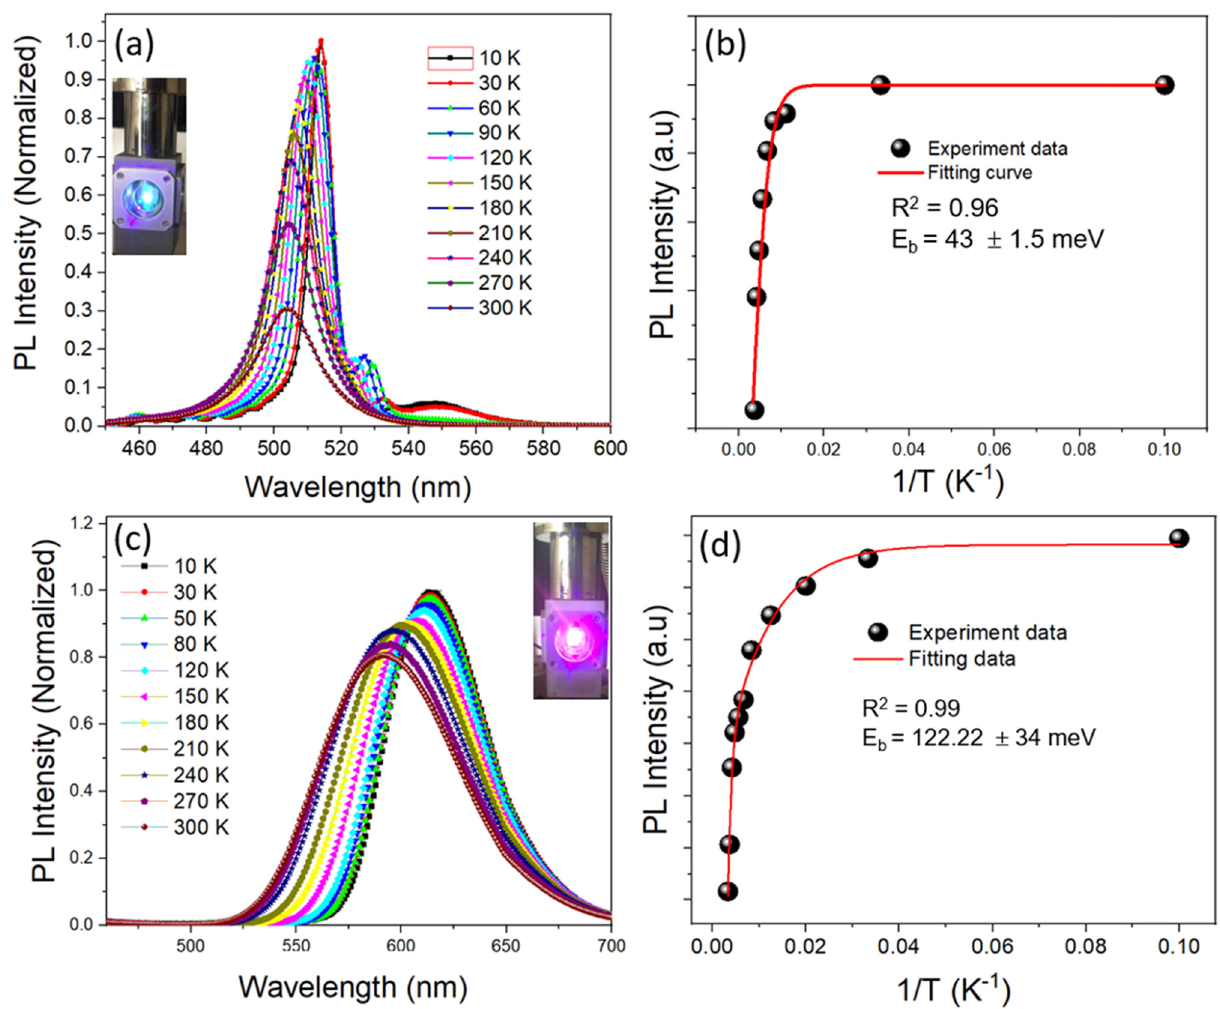
Figure 4: Temperature - dependent PL spectra and PL intensity versus inverse temperature and Arrhenius fi t of CsPbBr 3 NCs ( a and b ) and